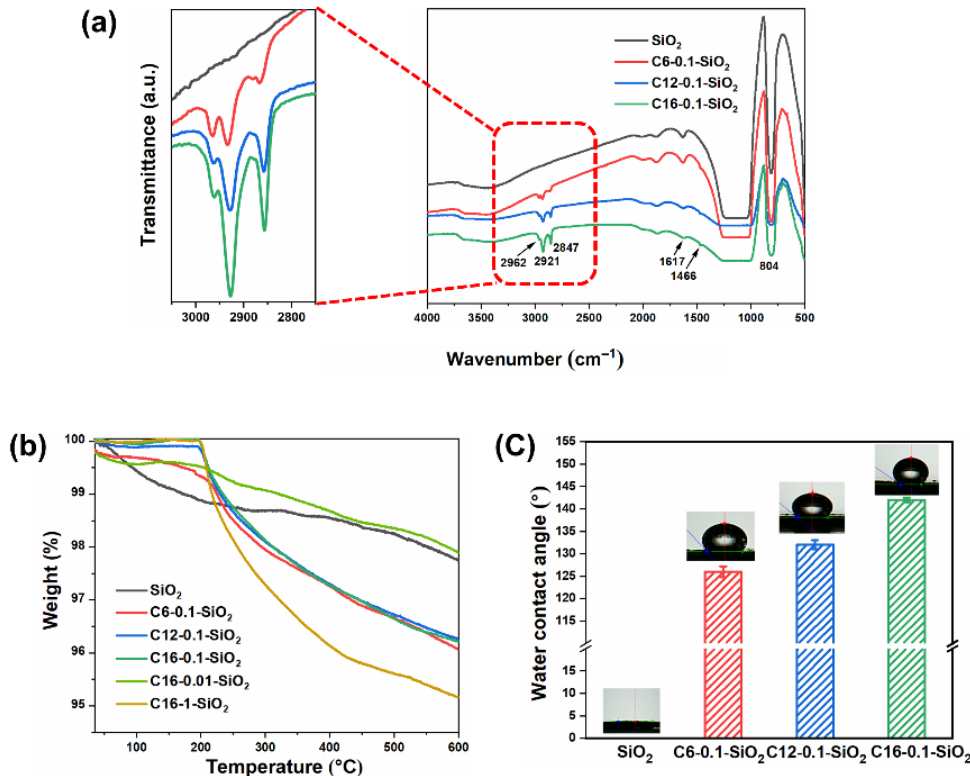
Figure 1. Characterization of unmodified and organically modified SiO 2 nanoparticles: ( a ) FTIR spectra, ( b ) TG curves, and ( c ) water contact angles.